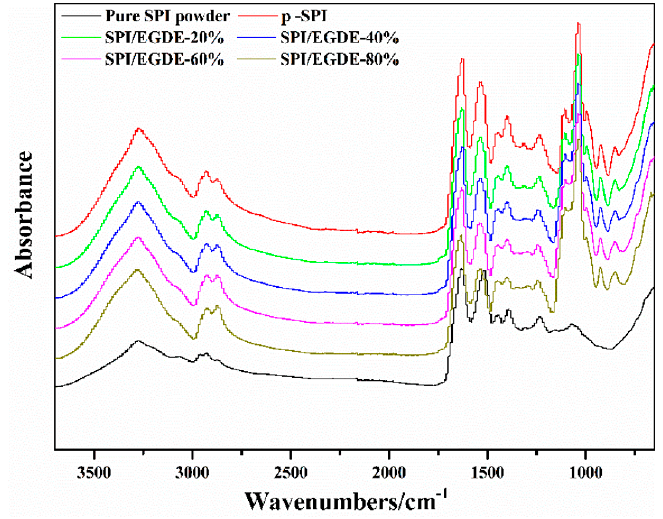
Figure 2. ATR-FTIR spectra of pure SPI powder and SPI membranes.